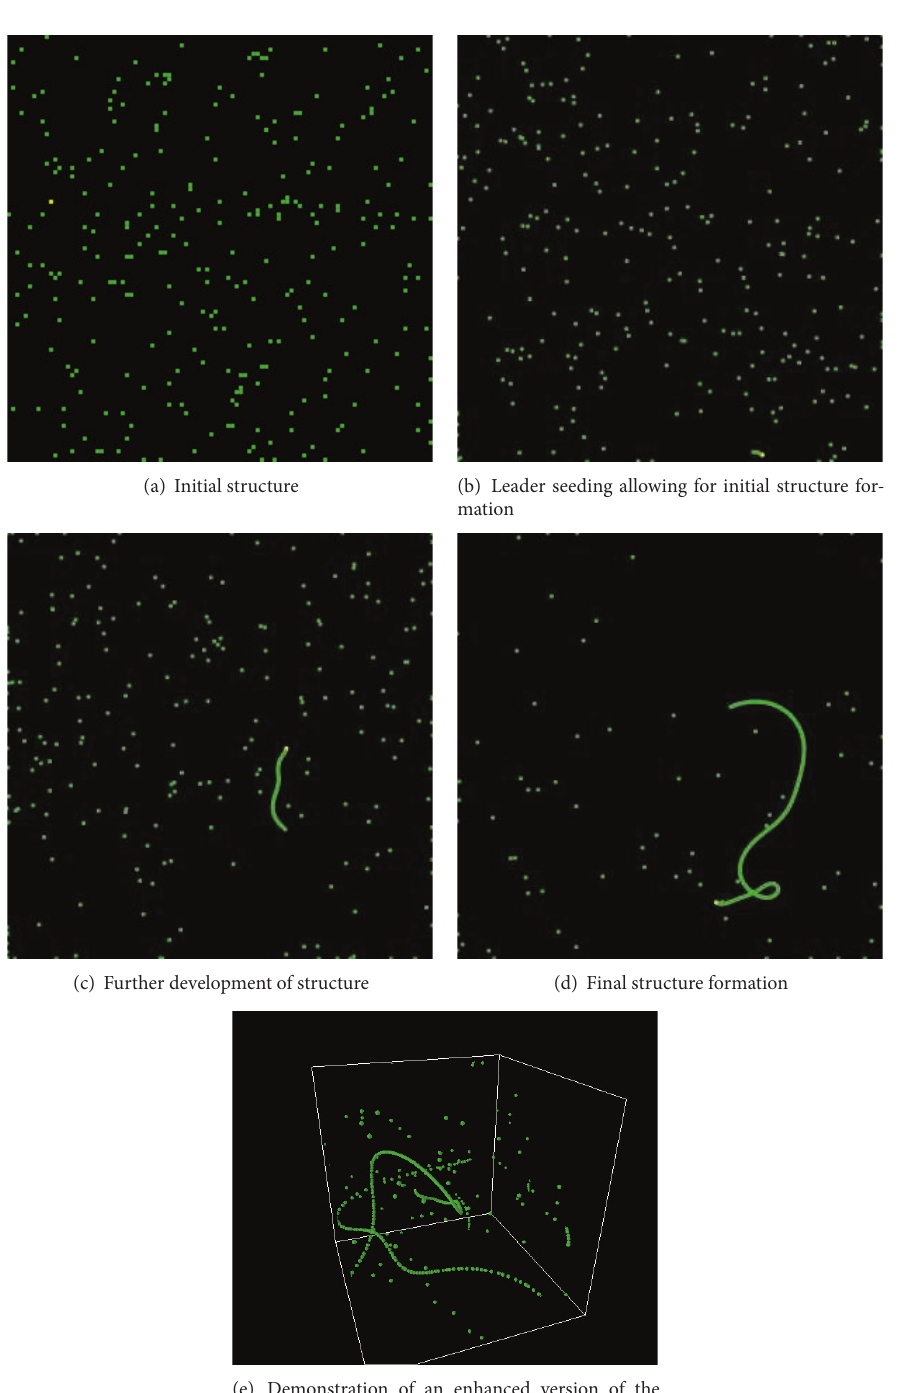
Figure 2: Detailed examination of